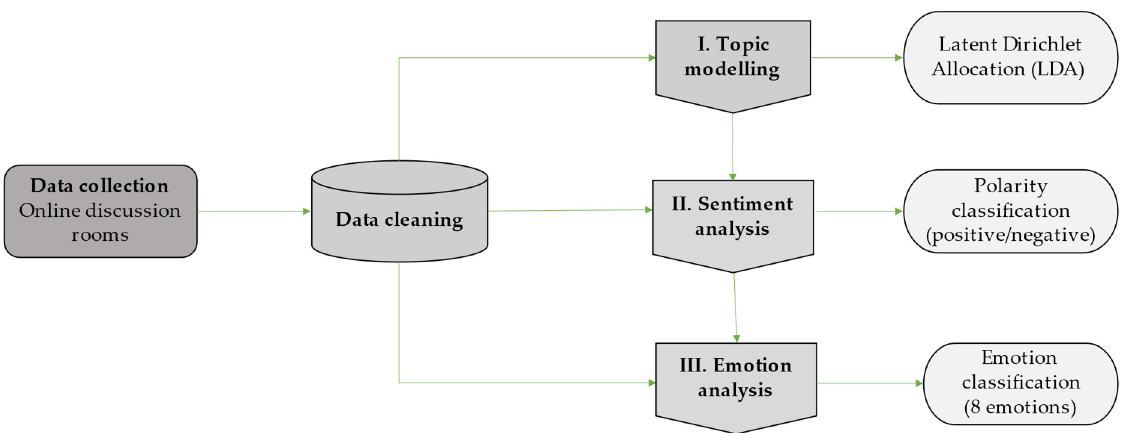
Figure 2. Data collection and processing outline, own